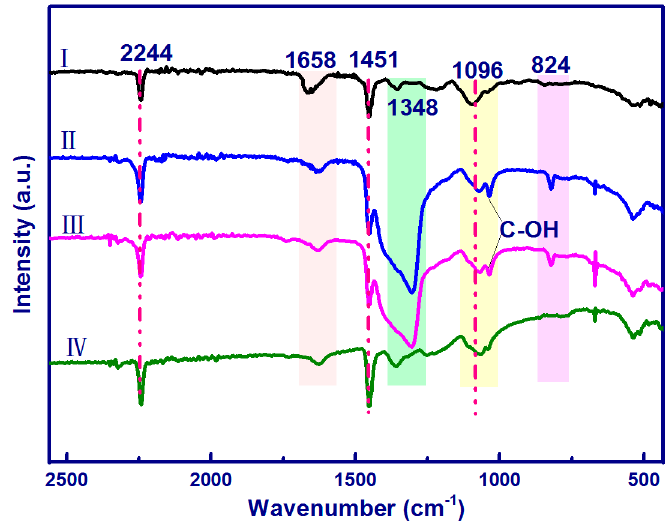
Figure 5. FTIR spectra of the electrospun nanofibers: ( I ) PAN; ( II ) PAN/CNC/Ag; ( III ) PAN/CNC/Ag/Si; and ( IV ) p-PAN/CNC/Ag/Si.